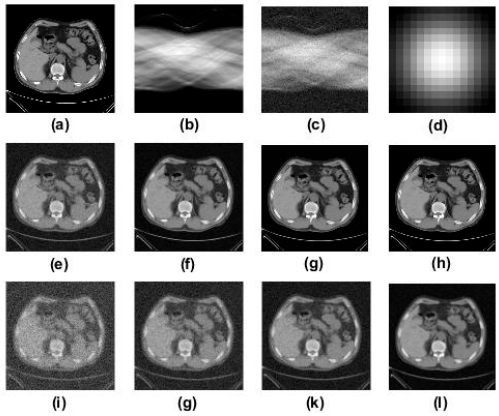
Figure 4. Experimental images and results of the fourth CT image. The 1st row shows the sharp CT image (left) and the CT noisy projection for 100% of measurements (middle) as well as the 15 × 15 point spread function; the 2nd row shows the blind restoration reconstruction results for 40%, 60%, 80% and 100% of measurements, respectively, from left to right (SNR = 40 dB); the 3rd row shows the blind restoration reconstruction results for 40%, 60%, 80% and 100% of measurements, respectively, from left to right (SNR = 20 dB). ( a ) the sharp CT image ; ( b ) the measured noisy projection (SNR = 40 dB); ( c ) the measured noisy projection (SNR = 20 dB); ( d ) the point spread function; ( e ) the reconstruction result (SNR = 40 dB, Sampling ratio = 40%); ( e ) the reconstruction result (SNR = 40 dB, Sampling ratio = 60%); ( f ) the reconstruction result (SNR = 40 dB, Sampling ratio = 80%); ( g ) the reconstruction result (SNR = 40 dB, Sampling ratio = 100%); ( h ) the reconstruction result (SNR = 20 dB, Sampling ratio = 40%); ( i ) the reconstruction result (SNR = 20dB, Sampling ratio = 60%); ( j ) the reconstruction result (SNR = 20 dB, Sampling ratio = 80%); ( k ) the reconstruction result (SNR = 40 dB, Sampling ratio = 40%); ( l ) the reconstruction result (SNR = 20 dB, Sampling ratio =